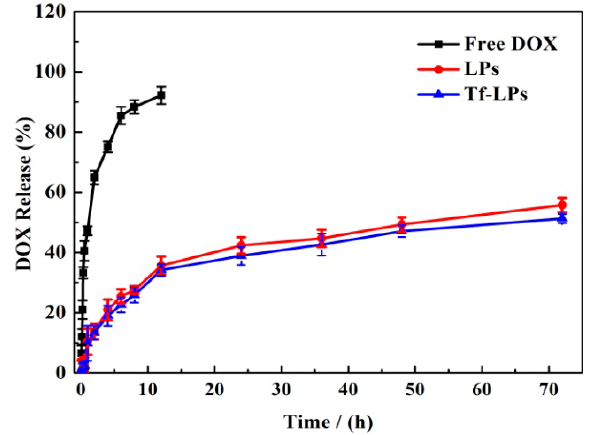
Figure 6. Release kinetics of free DOX, LPs, and Tf-LPs in PBS (pH 7.4, 0.01 M) ( n = 3). Free DOX was quickly released and the release was close to 90.0%. All DOX-loaded liposomes exhibited sustained release behaviors, ~50% of DOX was released from liposomes. Abbreviations: LPs, DOX-loaded liposomes; Tf-LPs, DOX-loaded Tf-liposomes.